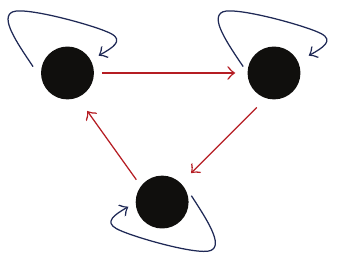
Figure 1: A typical MMN with flow storage at